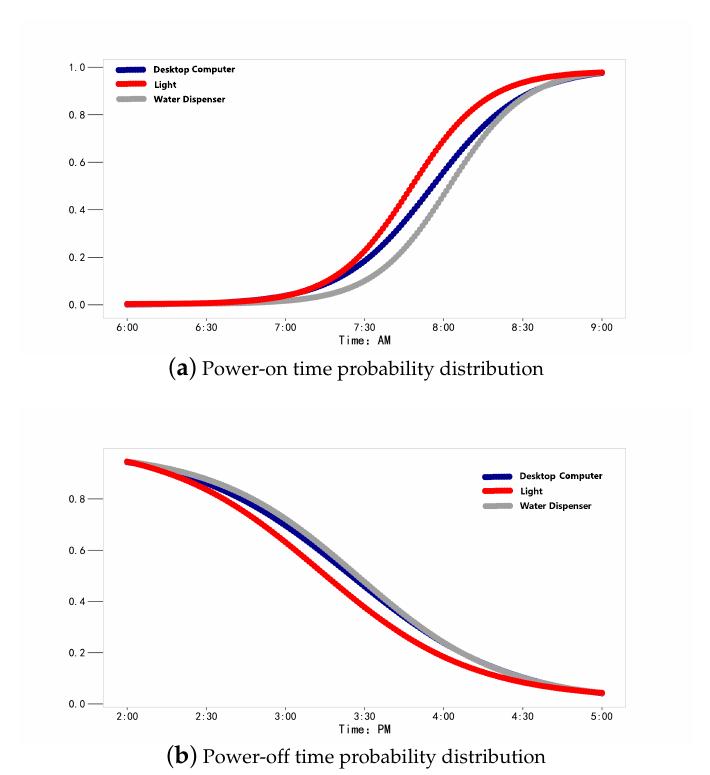
Figure 8. Energy use action time probability distribution.